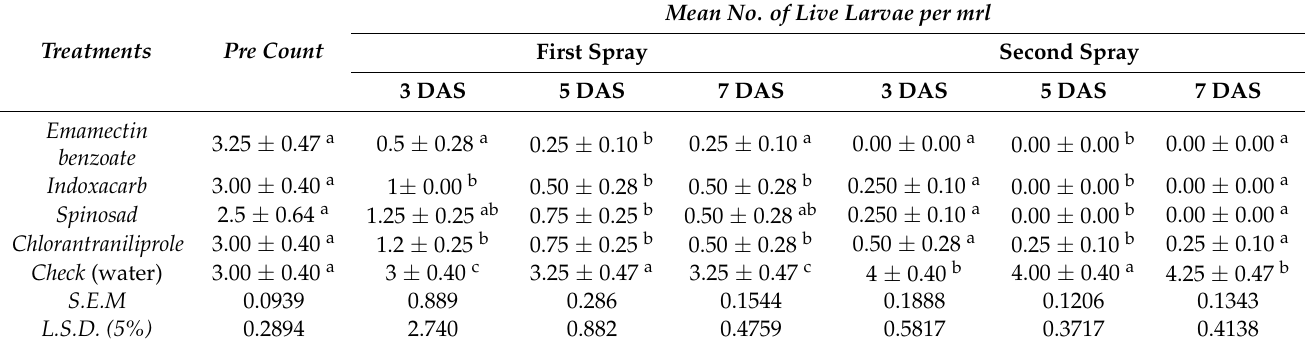
Table 5. Larvicidal activity of the insecticides, 3, 5, and 7 days after two sprays against the larvae of H. armigera under field conditions in Marchouch Station,